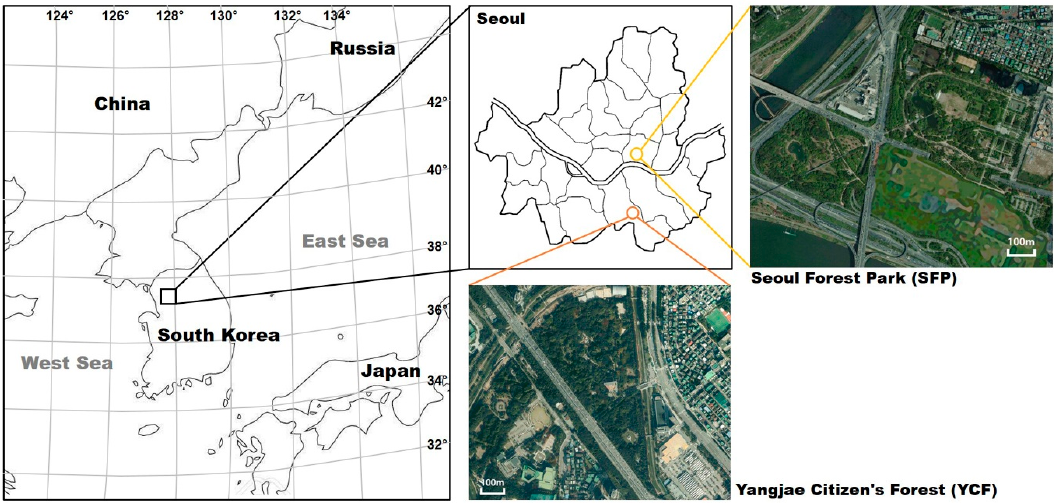
Figure 1. Location of two sampling sites in Seoul, South Korea: Seoul Forest Park (SFP) and Yangjae Citizen’s Forest (YCF). National Geographic Information Institute.